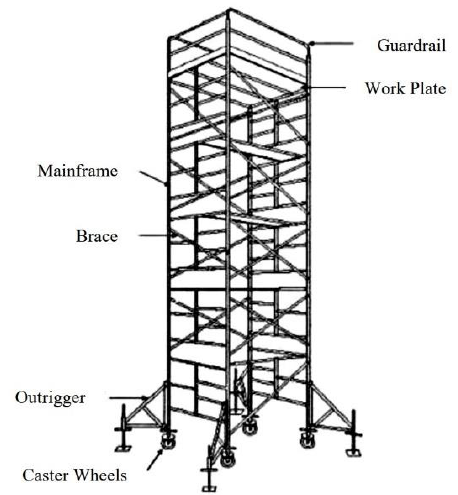
Figure 1. Components of mobile scaffold.